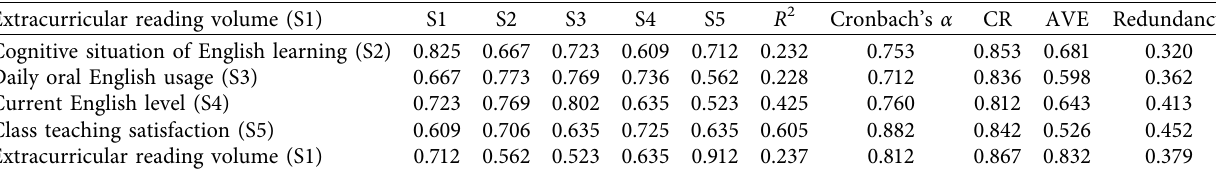
Table 3: Fitting of the model.